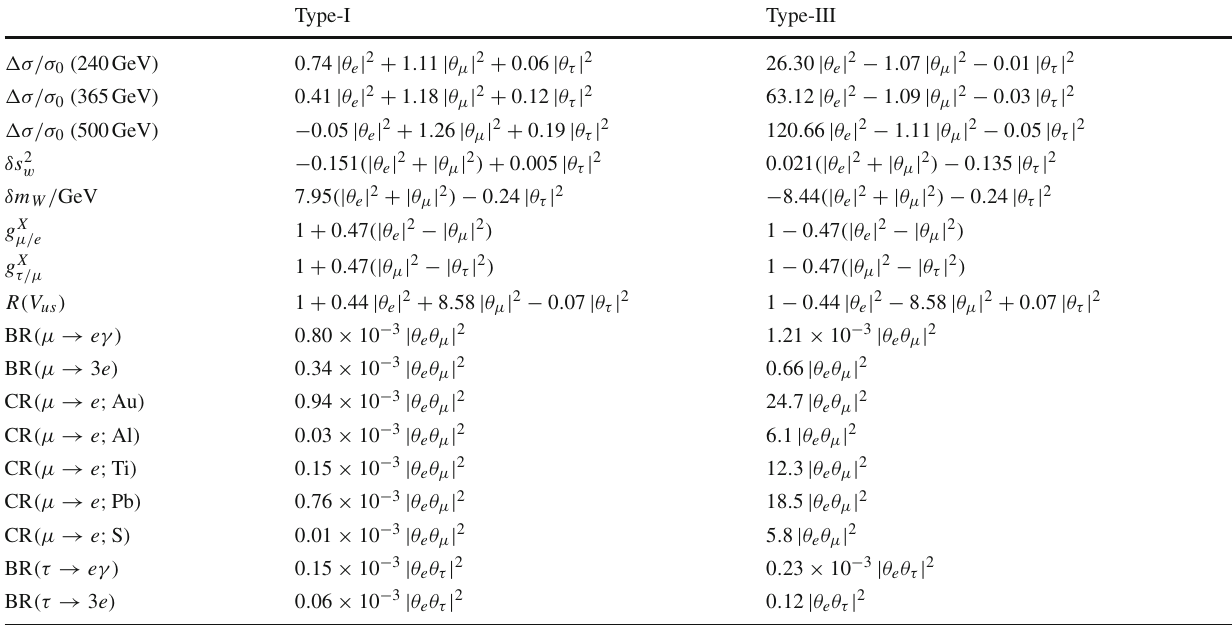
Table 8 Contributions to the observables considered in the phenomenology study in this work, but obtained from matching onto SMEFT at a Seesaw scale μ = M X = 10TeV Type-I